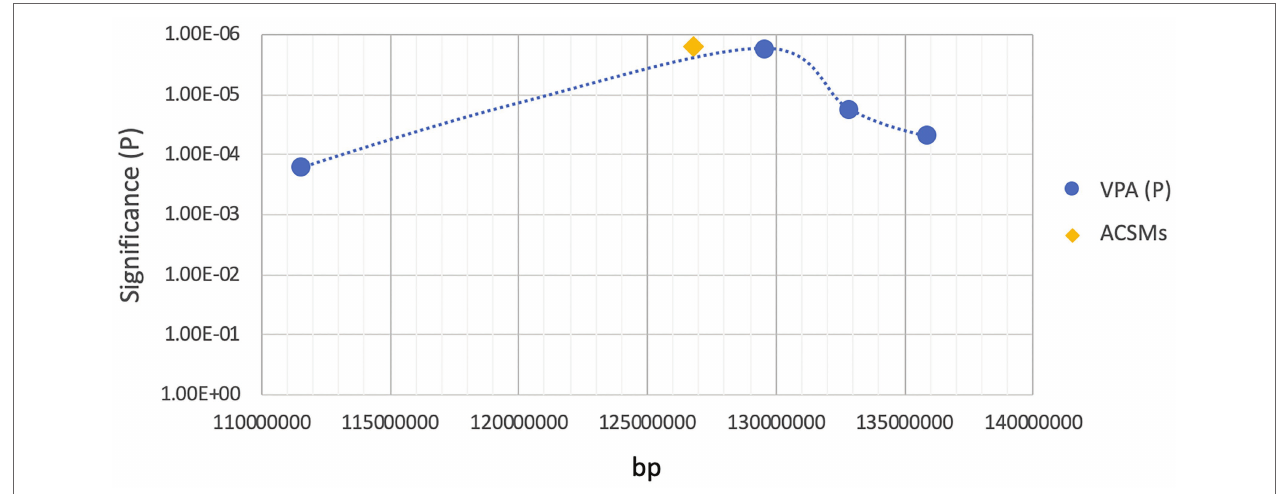
FIGURE 1 | Location of ACSM family genes in the region of high sensitivity to valproic acid (VPA)-induced neural tube defects